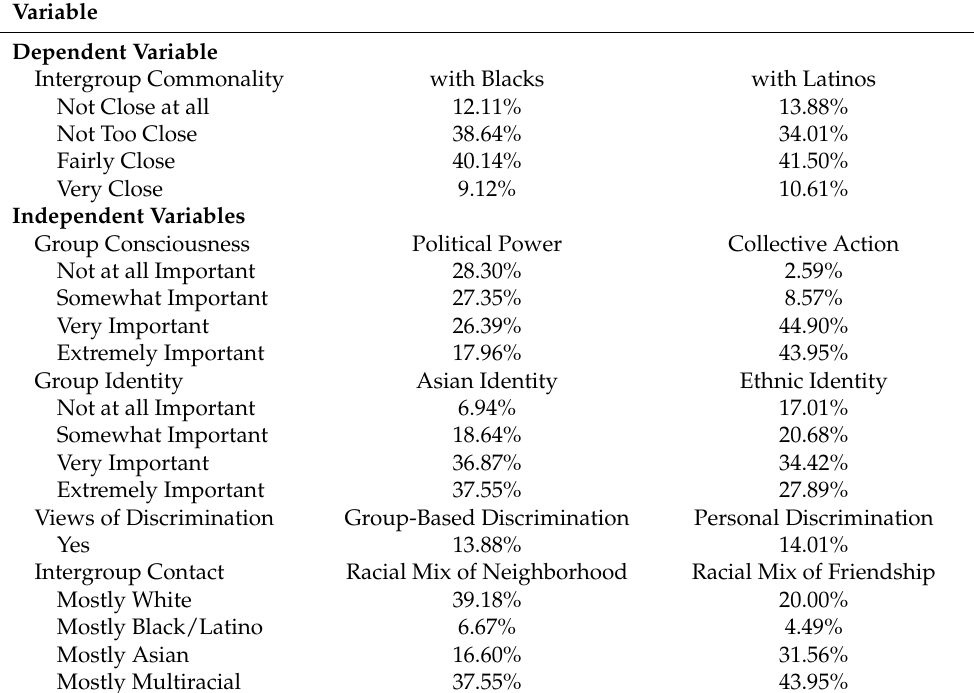
Table 2. Descriptive statistics of variables ( N =